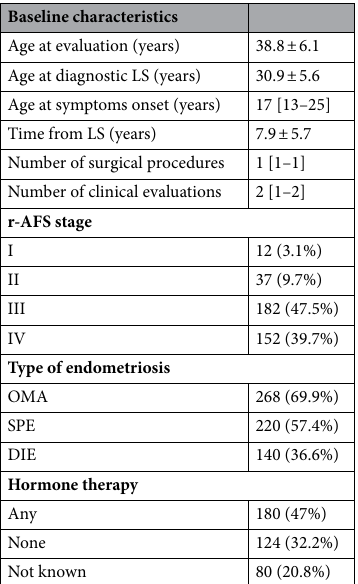
Table 1. Baseline characteristics of patients ( n = 384). Values are mean ± SD or median [25%-75%] or n (%). LS, laparoscopic surgery; r-AFS, revised American Fertility Society; OMA, ovarian endometrioma; SPE, superficial peritoneal endometriosis; DIE, deep infiltrating